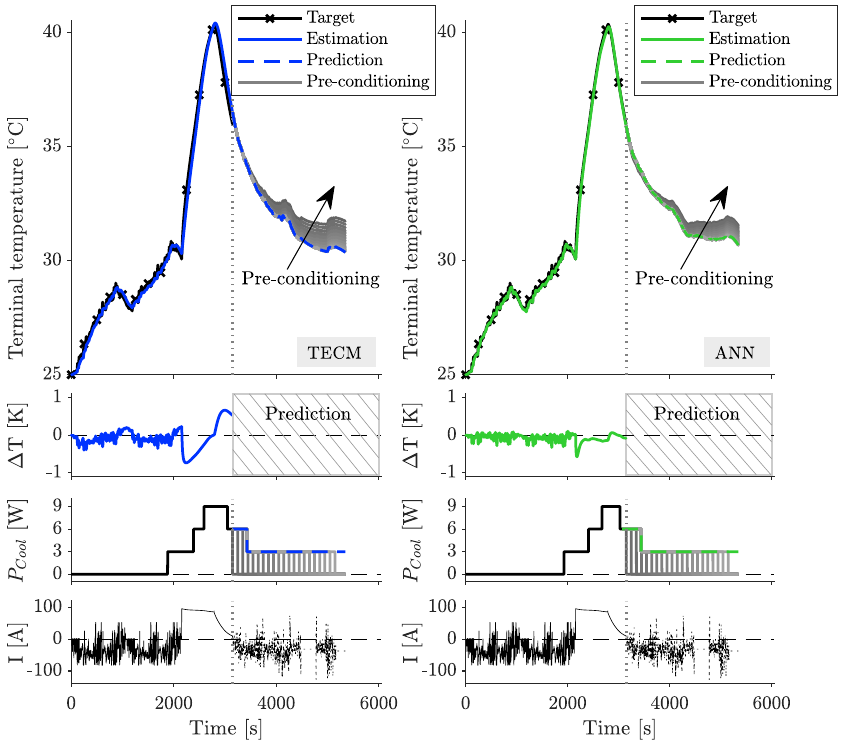
Figure 8. Temperature estimation and predictive cooling system regulation based on ANN/TECM thermal model integrated with an observer in a BEV